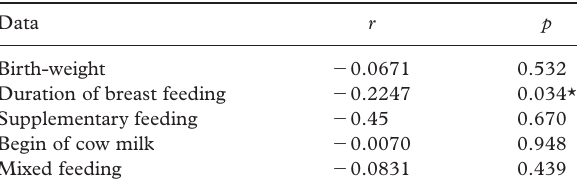
Table III. Correlation between characteristic data of infancy and SCORAD index in patients with AD.